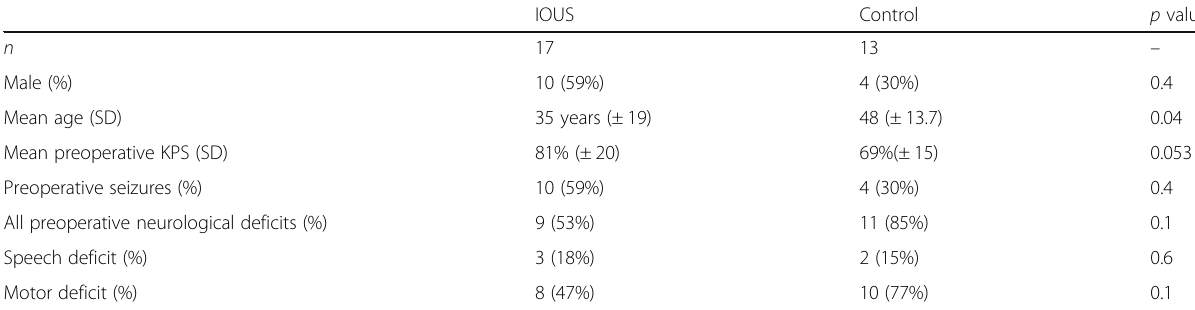
Table 1 Patient characteristics